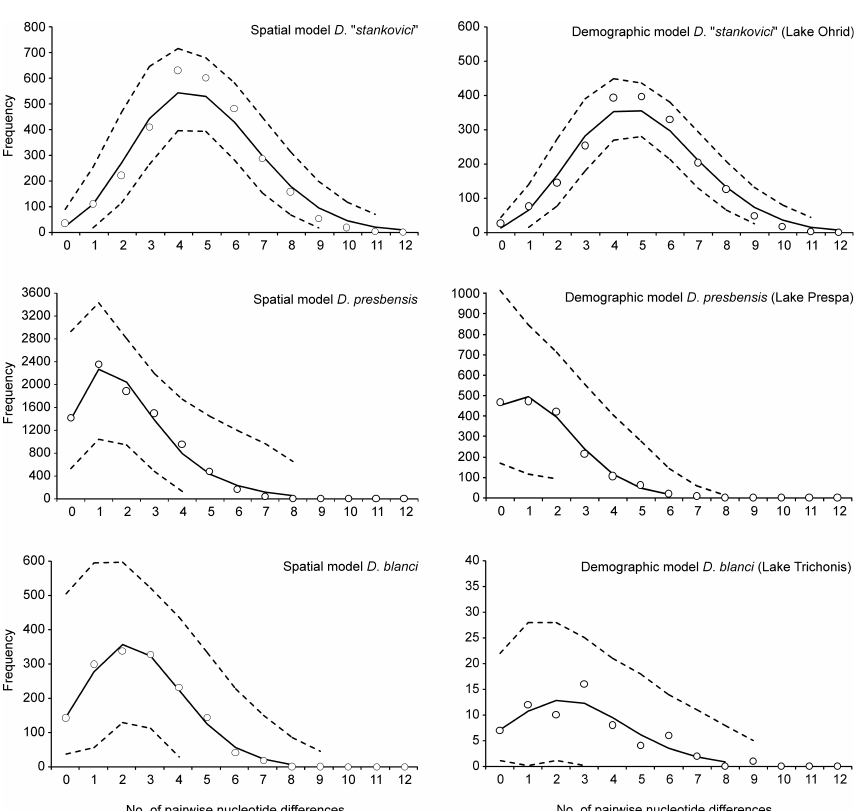
Fig. 3. Mismatch distribution of native Dreissena spp. based on COI mtDNA data. The distributions of pairwise nucleotide differences (circles) were tested against two expansion models (black lines): spatial expansion for all lakes (to the left) and demographic expansion out of the respective ancestral water body (to the right; see Result section for details). The 95% confidence intervals of the coalescent simulations are indicated by dashed